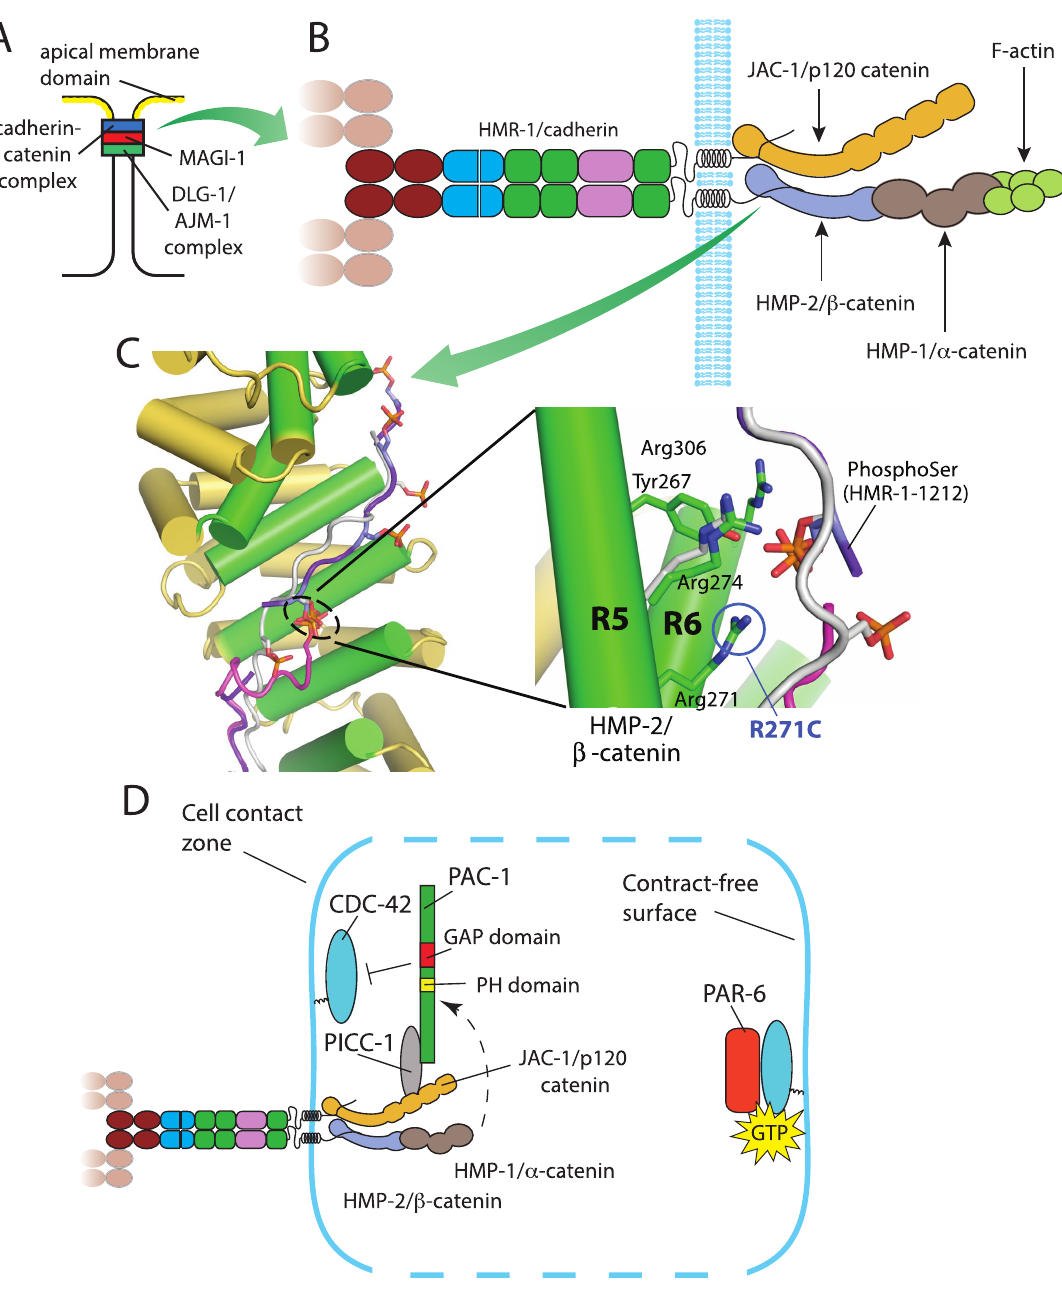
Figure 1. The classic cadherin-catenin complex (CCC) in Caenorhabditis elegans is a key regulator of morphogenesis and cell polarity. ( A ) Schematic of the C. elegans apical junction. MAGI-1 (membrane-associated guanylate kinase with inverted organization protein 1) localizes to a domain between the CCC and the DLG-1/AJM-1 complex. ( B ) The core components of the CCC. HMR-1A is the epithelial cadherin, HMP-2 the junctional β -catenin, HMP-1 the C. elegans α -catenin, and JAC-1 the p120ctn homolog. ( C ) Structures of HMP-2 (Armadillo repeats shown in gold and green) bound to the phosphorylated HMR-1 cytoplasmic domain (magenta). The structure of phosphorylated E-cadherin cytoplasmic domain bound to β -catenin is also shown superimposed on the structure (gray; PDB ID: 1I7W). Phosphoserine 1212 in HMR-1 interacts with residues in HMP-2, including R271, which is mutated to C in the canonical hmp-2 allele, zu364 . ( D ) A model for cadherin-induced cell polarization in blastomeres in the C. elegans embryo, based on 41. PAC-1 is recruited via CCC components to cell contact sites, where its GTPase-activating protein (GAP) domain negatively regulates CDC-42 at cell contacts to inhibit recruitment of PAR-6. The dashed line indicates a role that may not be direct. An inferred function that acts independently of the CCC via the pleckstrin-homology (PH) domain of PAC-1 is not shown for clarity. A is adapted from 13 with permission. B is adapted from 63 with permission. C is adapted with permission from a figure courtesy of Hee-Jung Choi by using data from